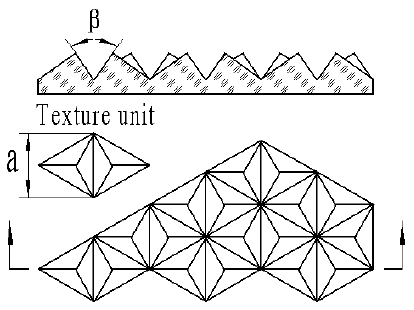
Figure 2. Triangular pyramid microstructure model.